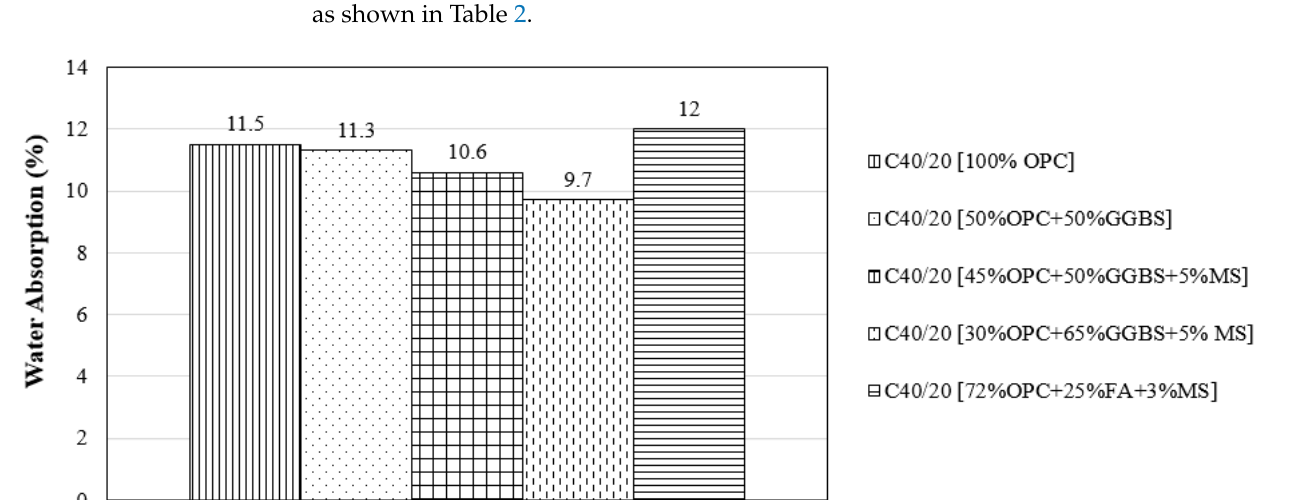
Figure 7. Average 28 day RCP result in accordance with ASTM C1202 for all investigated mixtures.